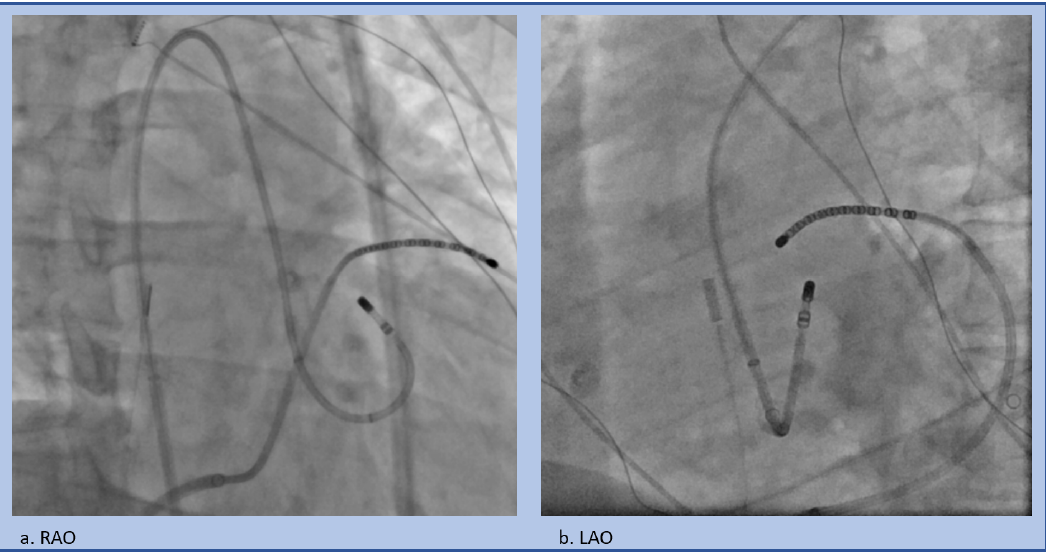
Figure 8. Retrograde approach to the LSoV, ( a ) RAO projection, ( b ) LAO projection. Anatomically, the LV summit is delineated as a triangle between the left anterior descending and left circumflex arteries; it is divided by the great cardiac vein/anterior interventricular vein junction into an inaccessible region superiorly and an accessible region inferior and laterally [35]. Ablating VT at the LV summit region can be challenging due to the thick muscle, multiple converging anatomic relationships (left sinus of Valsalva above and below the valve, RVOT, and GCV/AIV junction branches of the coronary sinus), and proximity to the epicardial coronary arteries. These cases require extensive forethought and planning. Our lab will often place a catheter in the coronary sinus and advance deep into the GCV/AIV region (Figure 7) to adequately bracket the VT location, as well as to provide anatomic reference on fluoroscopy and the mapping system. Very often the tissue is mid-myocardial or even closer to the epicardial surface and thus ablation from the en- docardium vantage points (above and below the left and right sinus of Valsalva), higher power and longer duration (several minutes) are usually required. One should consider mapping and ablating adjacent chambers for an anatomical vantage point even if slightly later or far-field as long as it is safe. Ablation within the distal coronary sinus and its distal branches has the issue of high impedance and coronary artery proximity which limits the ability to deliver adequate power, if at all, and may preclude ablation. One should always perform a coronary angi- ogram to delineate coronary artery anatomy and proximity prior to ablation from this region. Increasing irrigation flow prior to coming on ablation and gradual uptitration from a lower power can be helpful given the high impedance in this region. Subxiphoid epicardial access has at times been utilized but is usually not successful given the location relative to the coronary artery which precludes ablation, as well as the epicardial fat that precludes adequate ablation energy delivery to the key region. [36]. Challenging cases may require experimental techniques such as coronary venous branch or septal arterial ethanol ablation [37,38], surgical access for direct coronary visualization and separation from the myocardial site of interest [39], or direct intramyocardial ethanol injection [40] (Table 2).